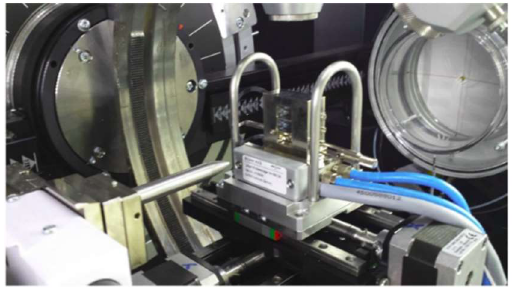
Figure 1. Setup of wide-angle X-ray scattering (WAXS) and small-angle X-ray scattering (SAXS).